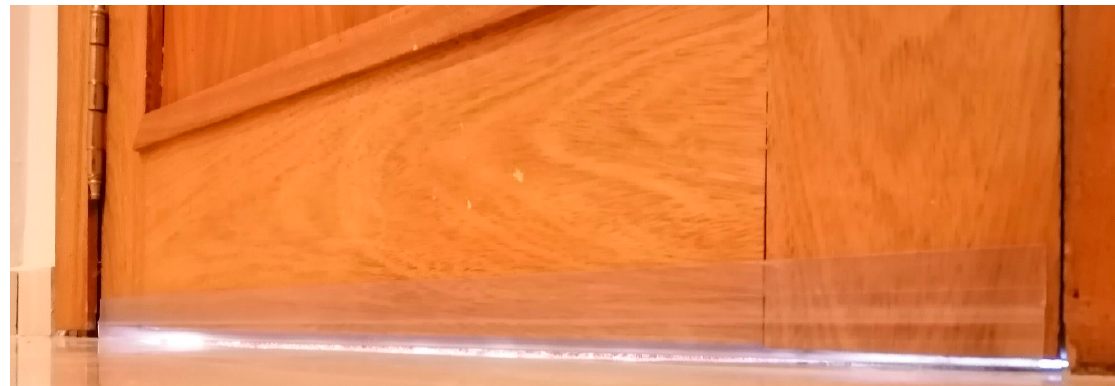
Figure 9. Weatherstripping to improve the thermal insulation of the house.